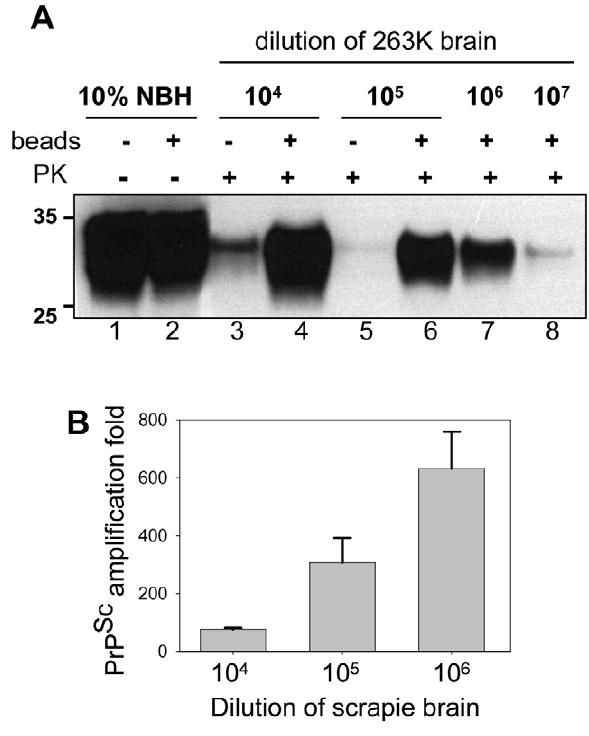
Figure 3. Beads improve the sensitivity of PrP Sc detection. ( A ) 263K scrapie brain material was serially diluted 10 4 -, 10 5 -, 10 6 - or 10 7 - fold into 10% NBH, subjected to 48 PMCA cycles in the absence of beads (lanes 3,5) or presence of five small beads (lanes 4,6,7,8) and digested with PK. Undigested 10% NBH (lanes 1,2) was loaded as a reference. ( B ) PrP Sc amplification in 48 cycles of PMCA conducted with five small beads for 263K scrapie brain material serially diluted 10 4 -, 10 5 - or 10 6 -folds as analyzed by dot blotting. The data represent average and standard deviation of three independent PMCA reactions. The amplification fold was calculated using calibration curve in Fig.